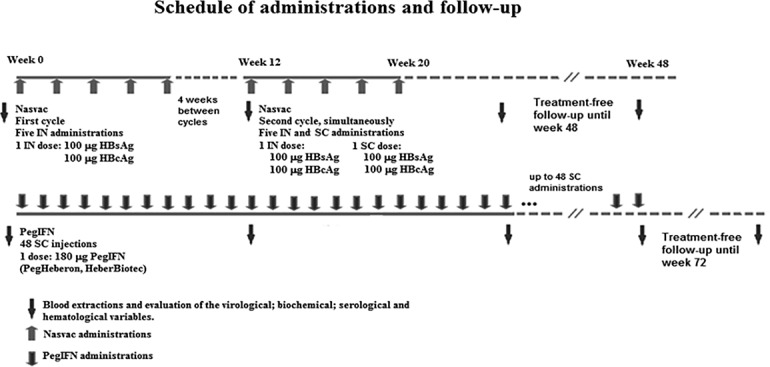
Schedule of administrations and follow-up.Time schedule of administrations, blood extractions, frequency and number of administrations as well as the administration route and composition of treatment and control groups (Nasvac and PegIFN).